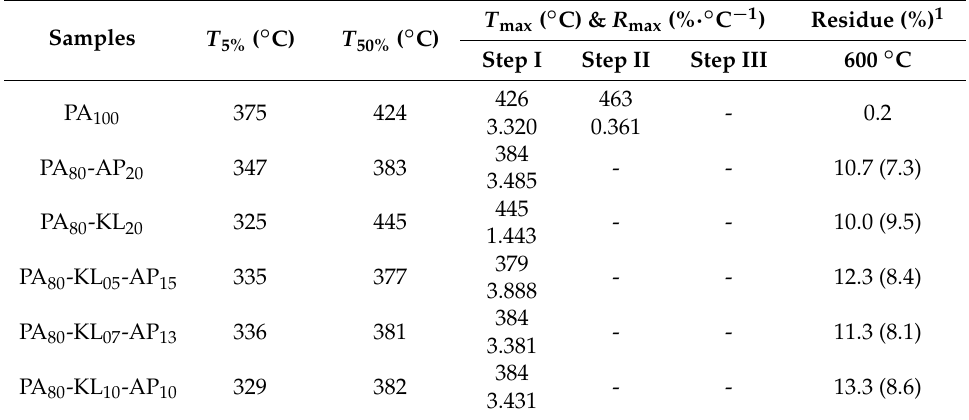
Figure 3. TG and DTG curves of PA and PA blends with AP and KL under nitrogen atmosphere. Table 3. TGA results of PA and blends with lignin and/or ammonium polyphosphate under nitrogen